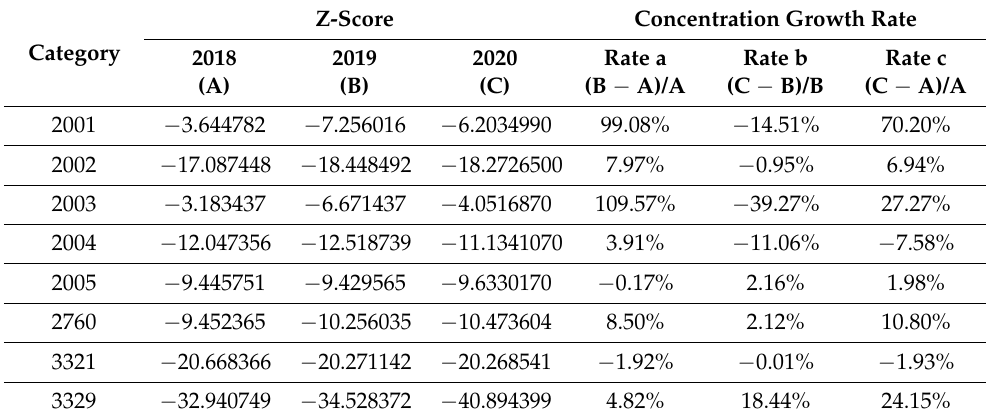
Table 3. Z-score of ANN analysis for spatial distribution of the